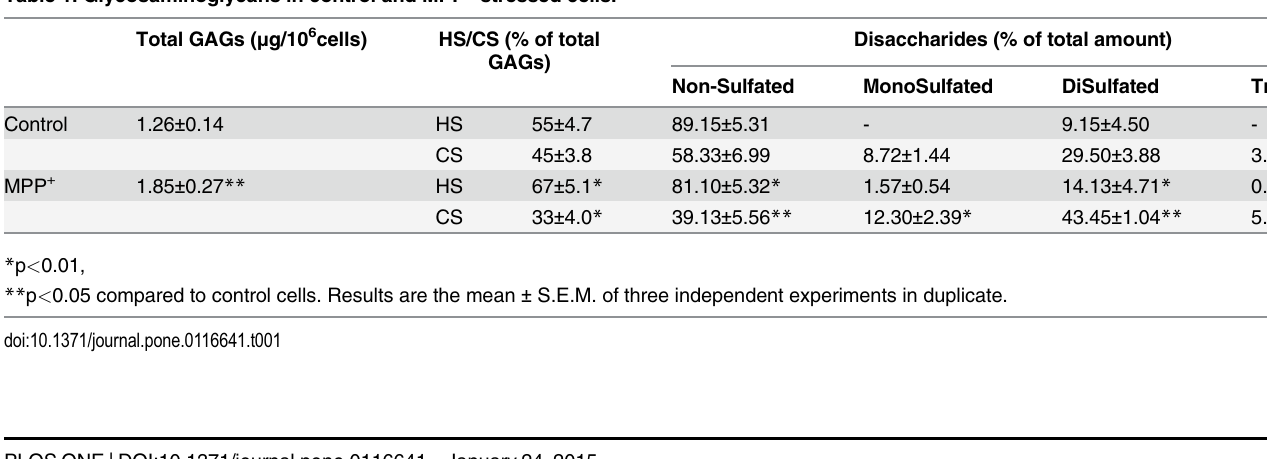
Table 1. Glycosaminoglycans in control and MPP + -stressed